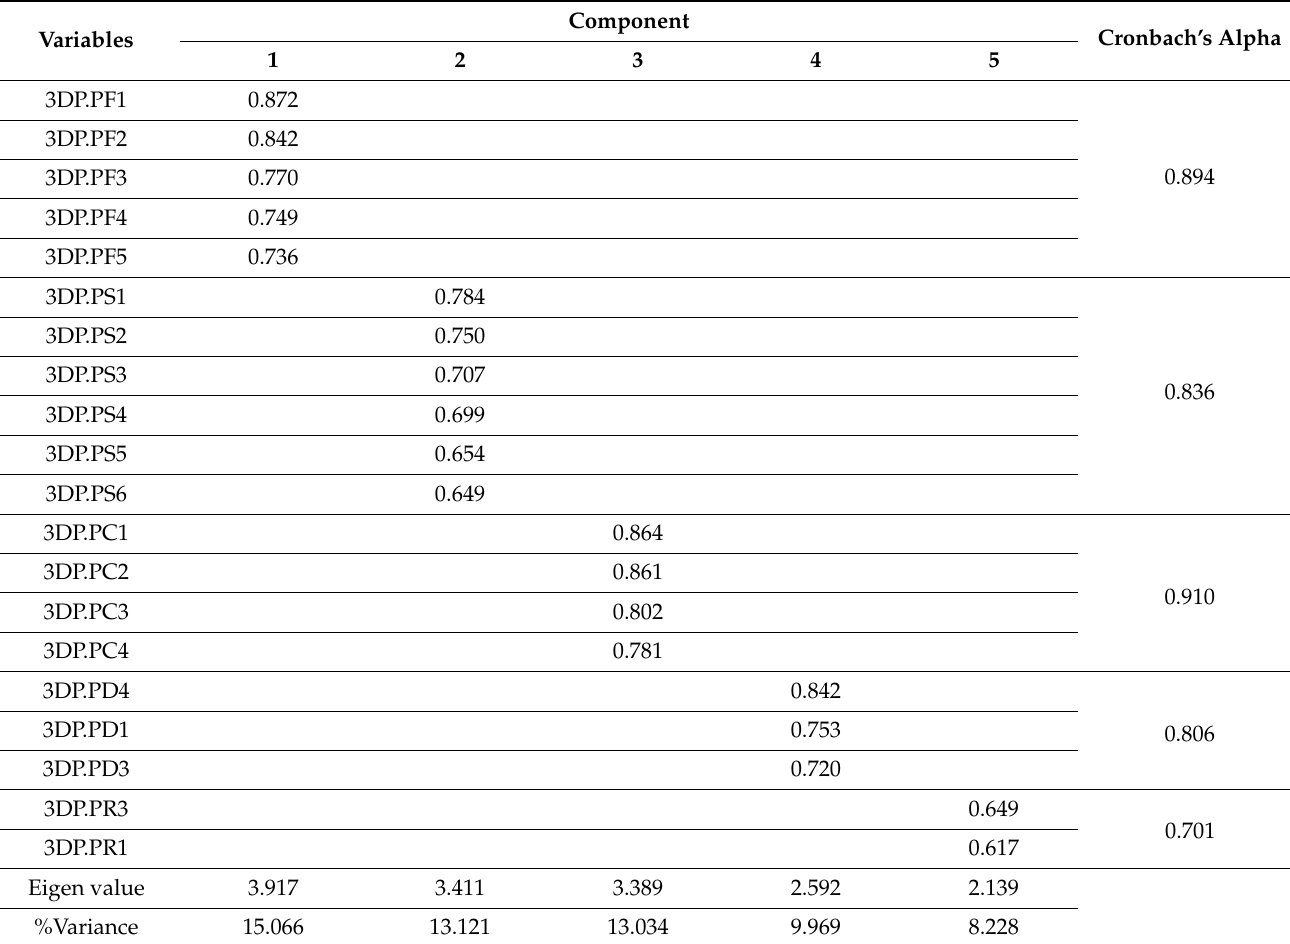
Table 3. Rotated component matrix with reliability